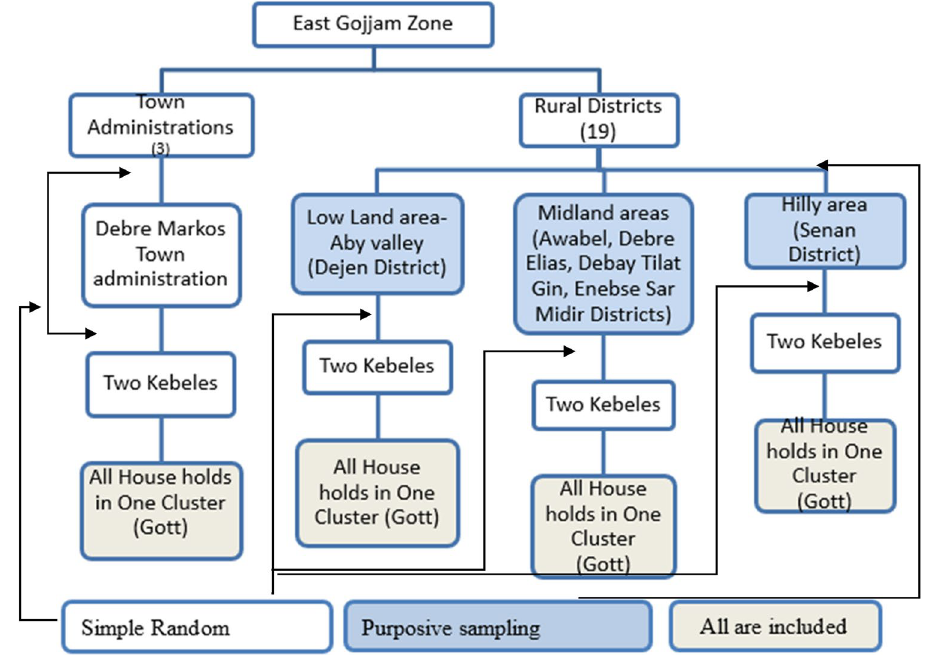
Figure 1. Schematic presentation of the sampling